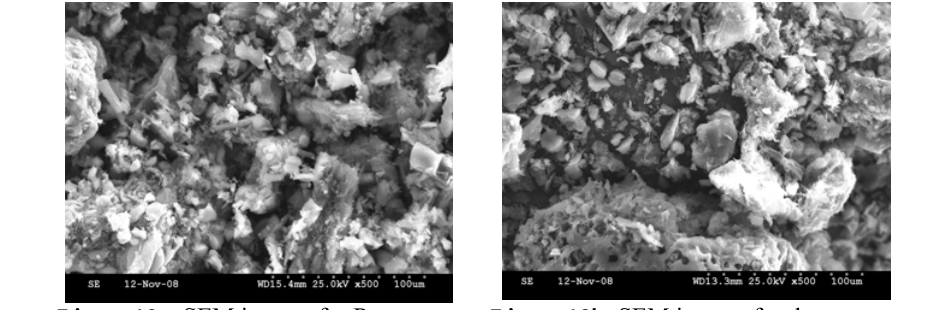
Figure 12a. SEM images for Raw Cynodon dactylon